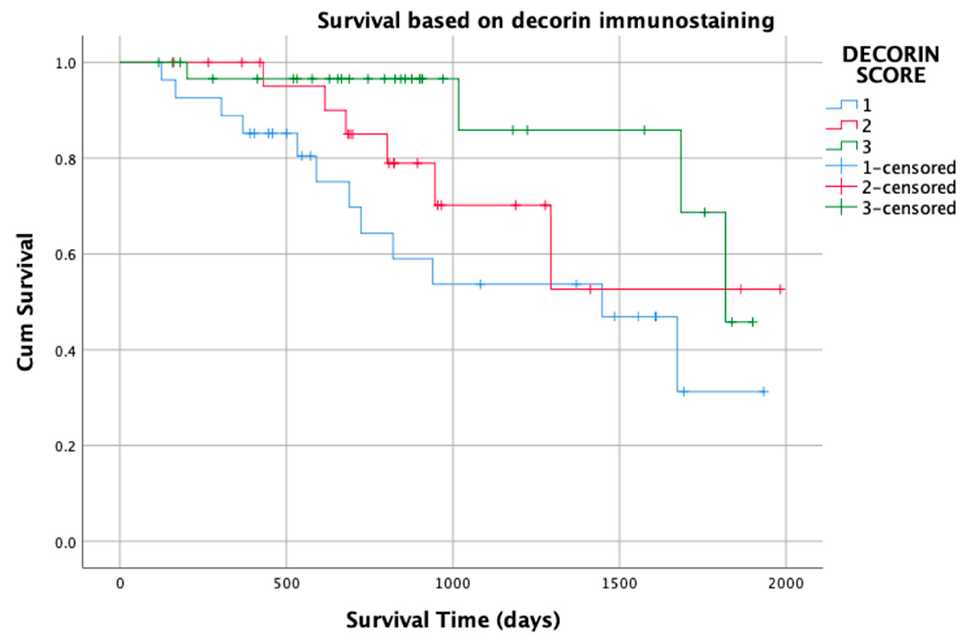
Figure 5. Kaplan–Meier graph of survival time for 83 patients with soft tissue sarcoma based on decorin immunostaining pattern (types 1, 2 and 3).